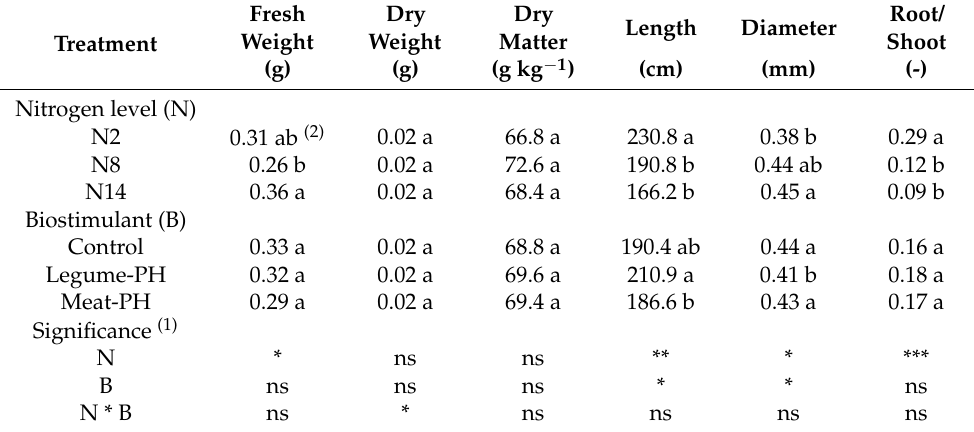
Table 2. Growth and morphology of spinach roots as affected by nitrogen nutrition and by the foliar application of